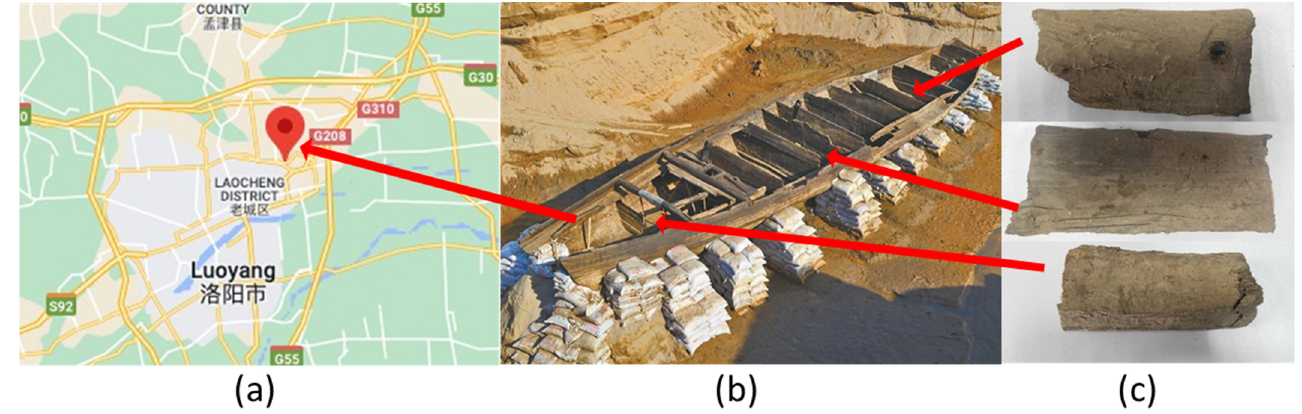
Figure 1. Basic information of Luoyang No.1 ancient Ship: ( a ) Excavation location; ( b ) ancient ship; ( c ) Wood samples extracted from keels of ancient ships.